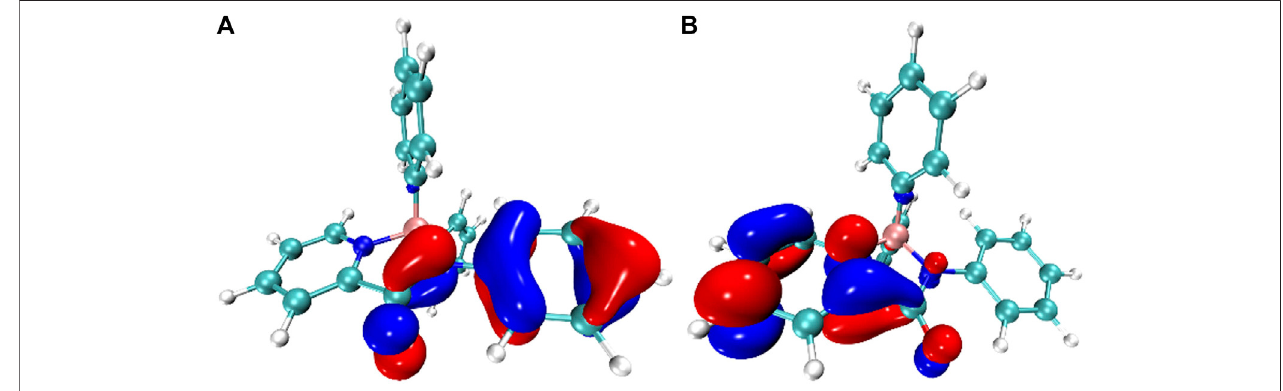
FIGURE 5 | The calculated HOMO (A) and LUMO (B) orbitals of 3a